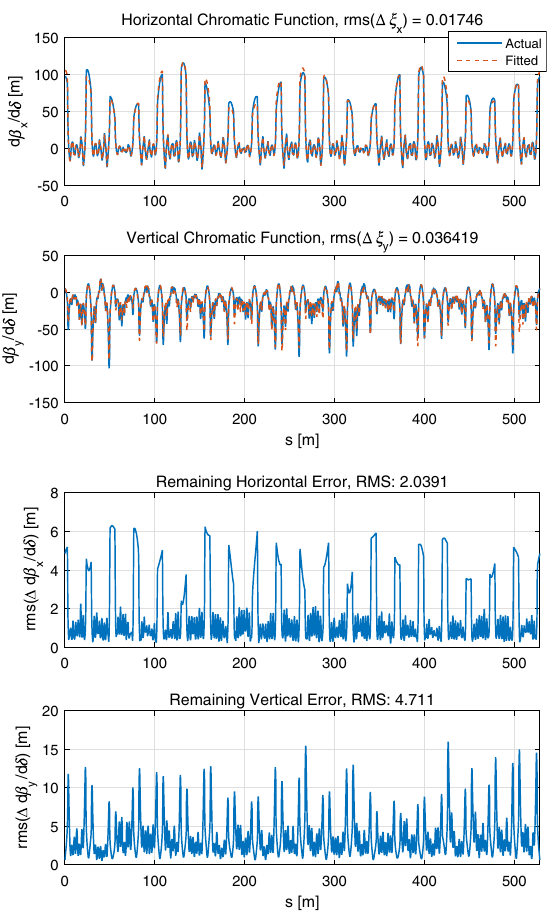
FIG. 8. The chromatic functions of one seed with sextupole magnet errors and the fitted model (top), and the RMS remaining error calculated from 10 error seeds